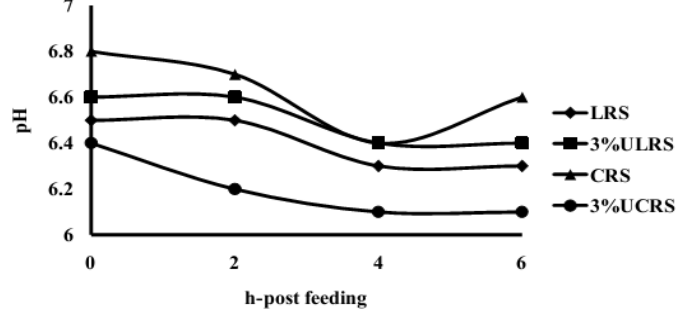
Figure 1. Effect of physical form and urea treatment of rice straw on ruminal pH at 0, 2, 4, and 6 h-post feeding in dairy